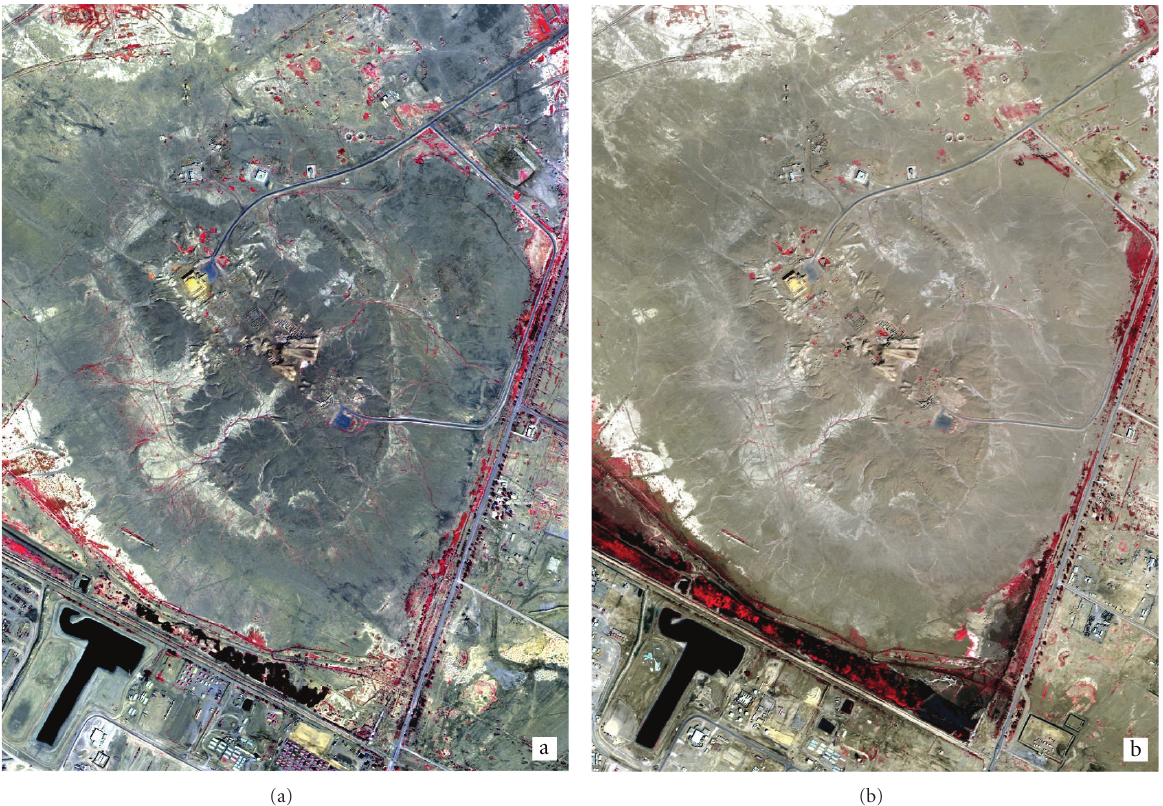
Figure 6: Ur in a pan-sharpened QuickBird-2 image of April 2004 (colour composite RGB bands 4-3-1) and in a pan-sharpened QuickBird-2 image of March 2007 (colour composite RGB bands